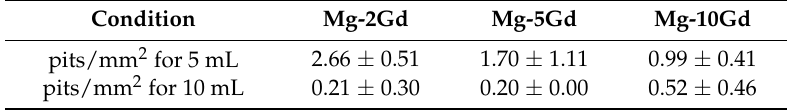
Table 4. Number of etching pits formed in the Mg- x Gd alloys after etching for 150 s in 5 and 10 mL solutions.